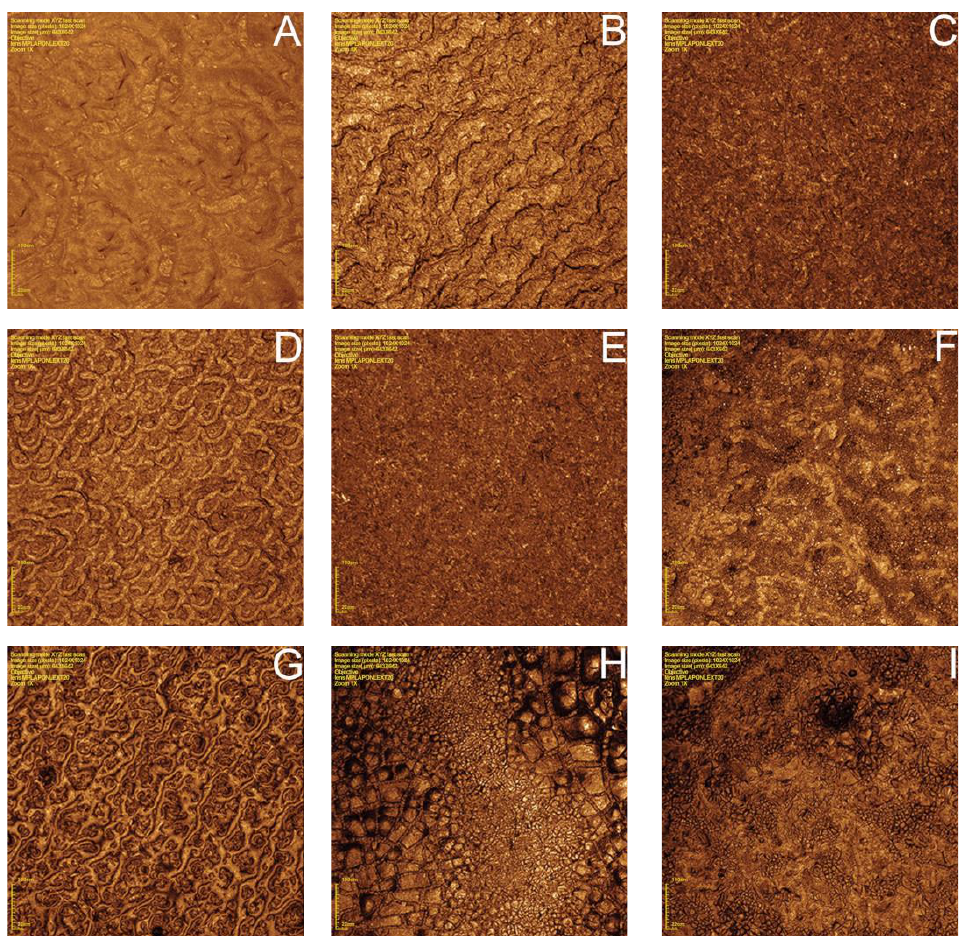
Figure 4. Images of the surface morphology of the disks in different experimental conditions (432× magnification): ( A ) before sintering; ( B ) after sintering; ( C ) silicatization; ( D ) HF 40%; ( E ) HF 40% + silicatization; ( F ) ZrO 2 nanoparticles; ( G ) SiO 2 nanoparticles; ( H ) ZrO 2 + SiO 2 nanoparticles (50% – 50%); ( I ): ZrO 2 + SiO 2 nanoparticles (50% – 50%) + silane.